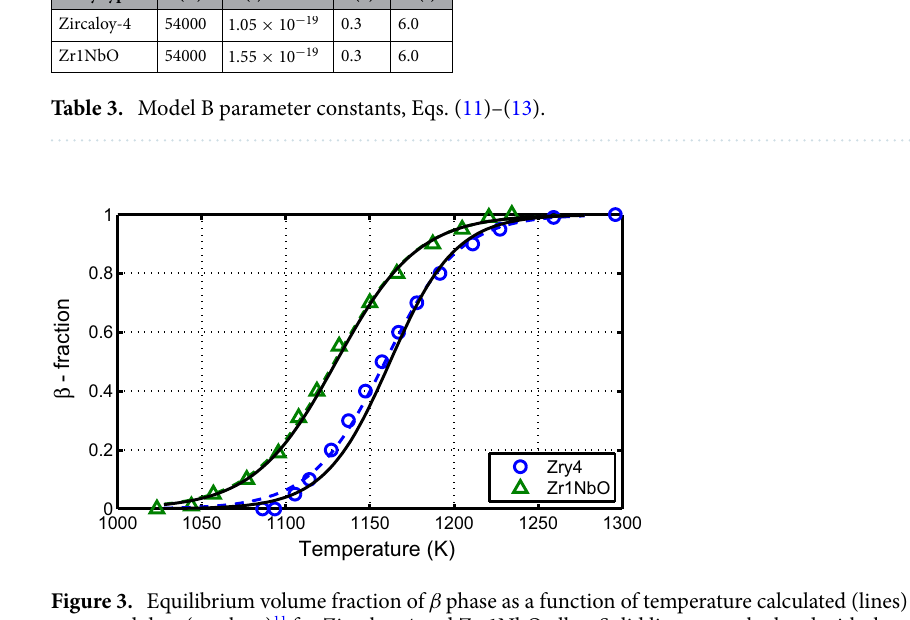
Figure 3. Equilibrium volume fraction of β phase as a function of temperature calculated (lines) versus measured data (markers) 11 for Zircaloy-4 and Zr-1NbO alloy. Solid lines are calculated with the model parameters listed in Table 2 whereas the dashed lines are those from ref. 13 .